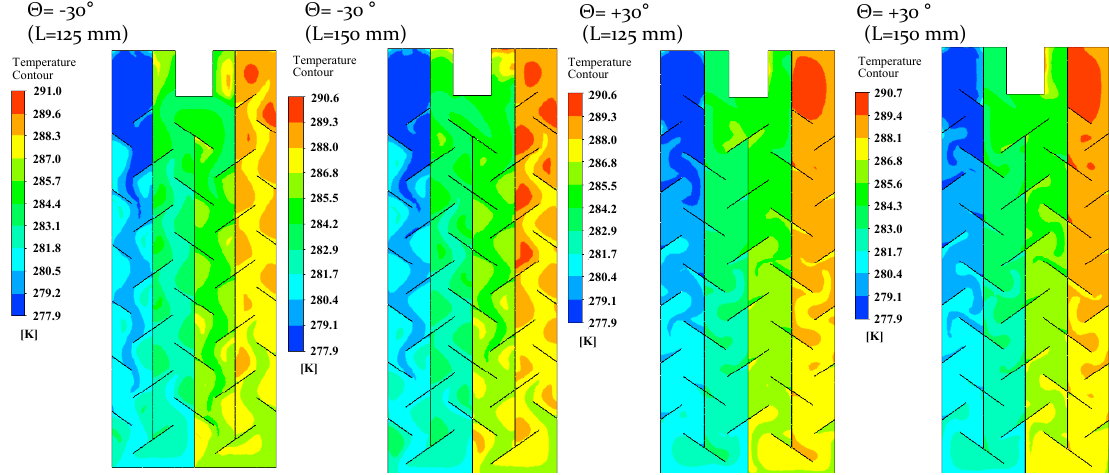
Figure 9. Baffle slope and length effect on temperature contours Figure 9. Ba ffl e slope and length e ff ect on temperature